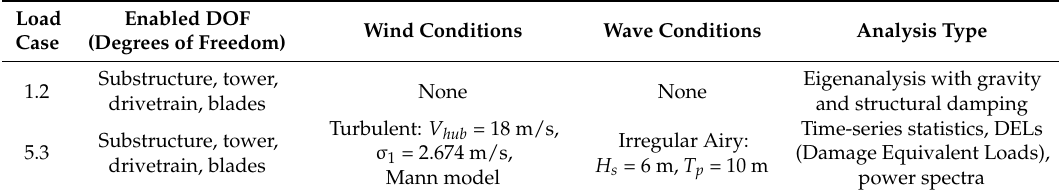
Table 1. Load Cases Definitions of OC3 (Offshore Code Comparison Collaboration) Phase I.